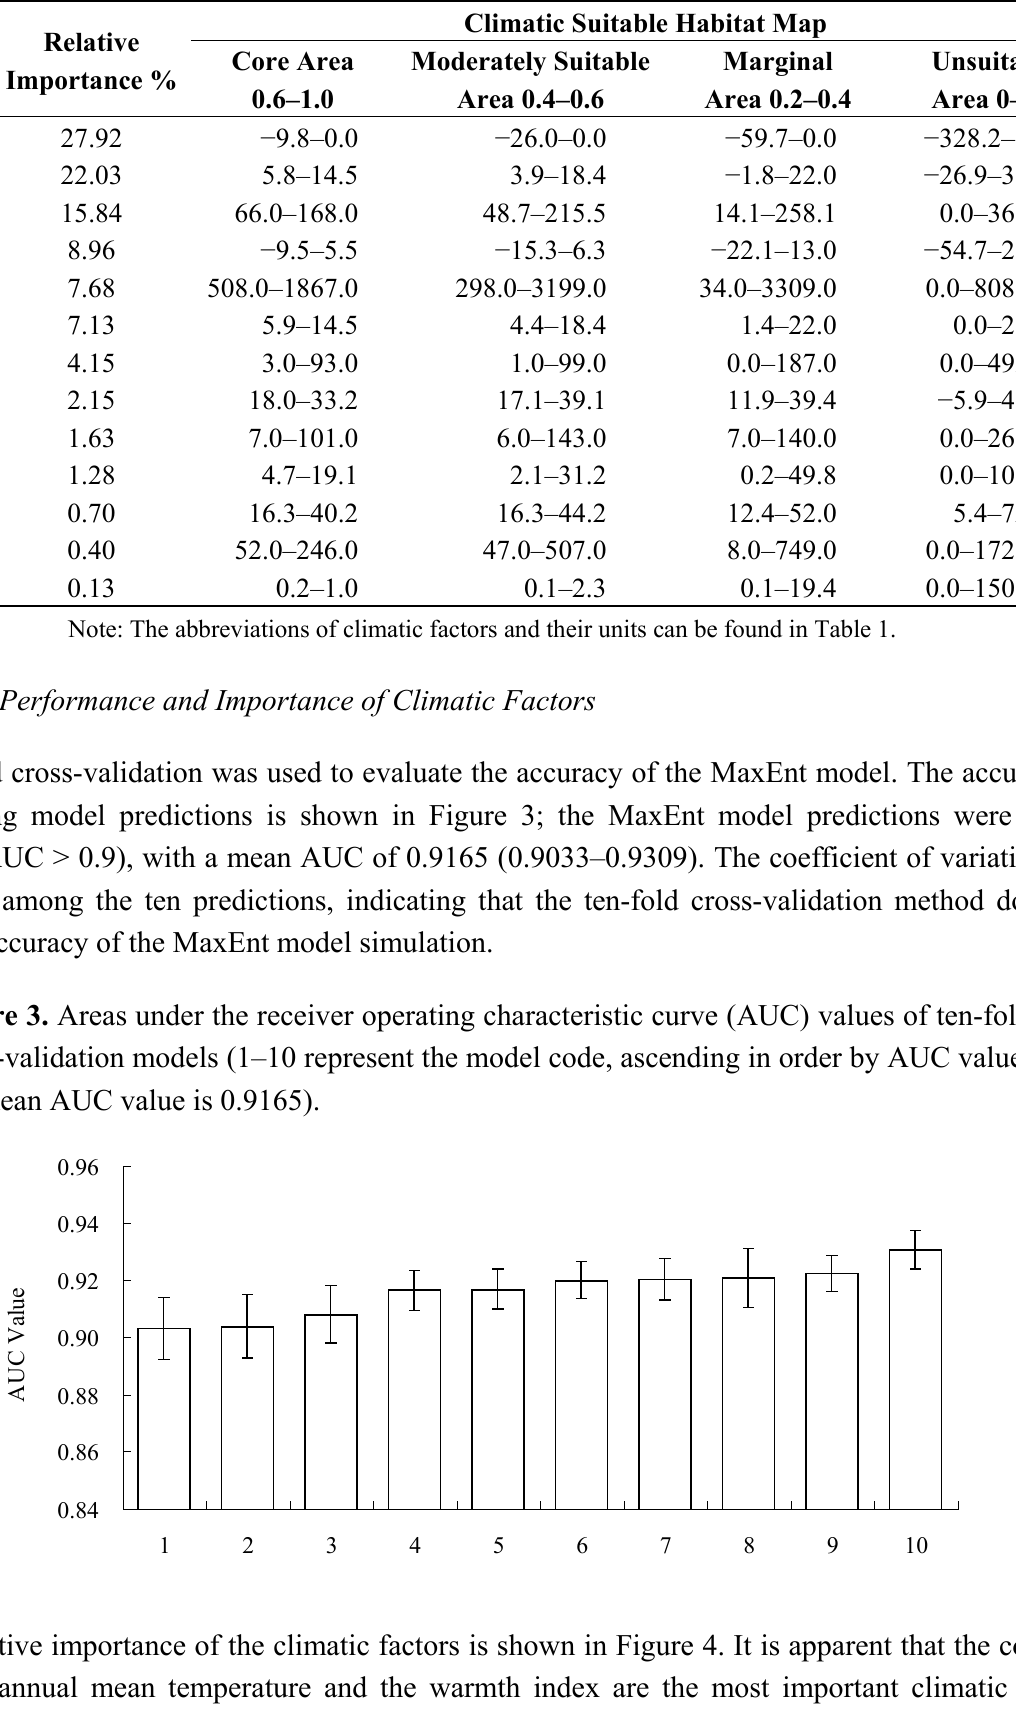
Table 2. Climatic threshold of black locust suitable habitat map predicted by the MaxEnt model.